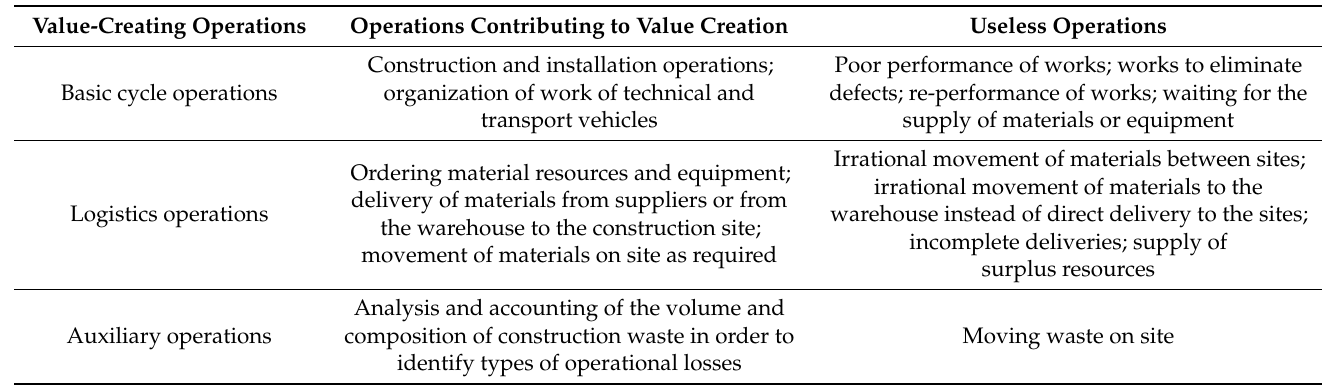
Table 2. Typology of operations in construction according to the criterion of value